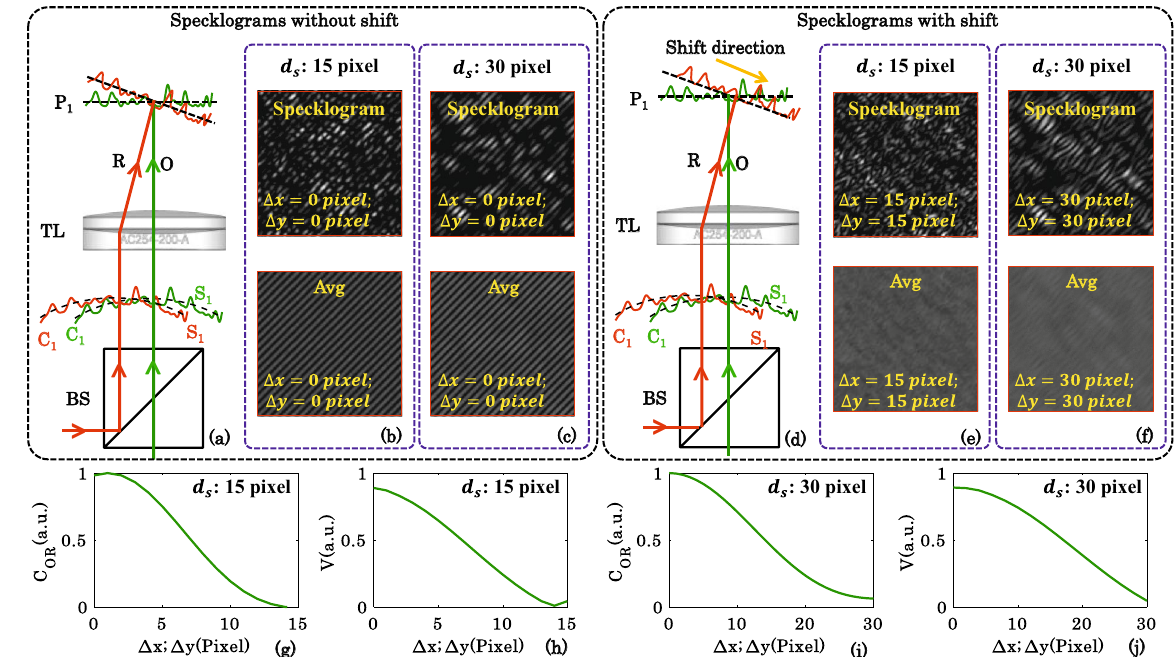
Figure 3. Correlation study with shift only in one speckle fields and speckle size. The correlation between the identical speckle fields as a function of shift of one of the speckle fields being superimposed to generate resultant intensity pattern. ( a – c ) Represent the optical configuration, specklogram and averaged interferogram corresponding to the superposition of unshifted correlated speckle fields of speckle sizes 15 pixels and 30 pixels, respectively. ( d – f ) Represent the optical configuration, specklogram and averaged interferogram corresponding to the superposition of shifted correlated speckle fields of speckle sizes of 15 pixels and 30 pixels, respectively. ( g , i ) Illustrate the variation of correlation values between the speckle fields as a function of the shift in a step of 1 pixel corresponding to speckle fields of speckle sizes of 15 pixels and 30 pixels corresponding to the window sizes ‘D’ of 30 pixels and 15 pixels, respectively. ( h , j ) Corresponding fringe visibility plot obtained from the averaged